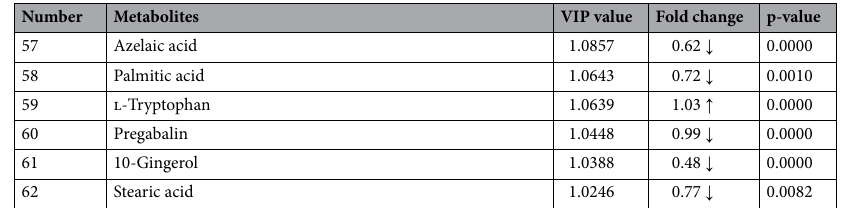
Table 1. List of metabolites from T. controversa infected and non-infected wheat grains (VIP > 1). ↑ indicates the up-regulation and ↓ indicate the down-regulation of the metabolite.